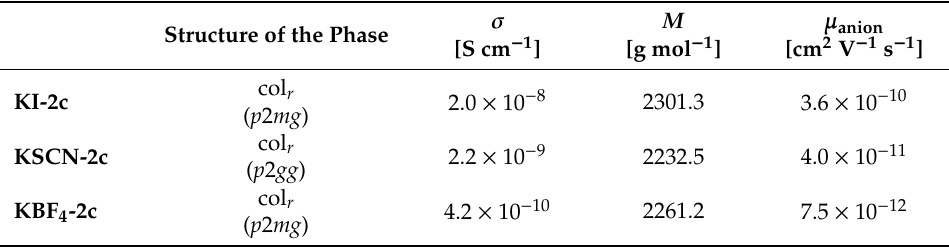
Table 1. Calculated anion mobility in the columnar rectangular mesophases of KI-2c , KSCN-2c ,